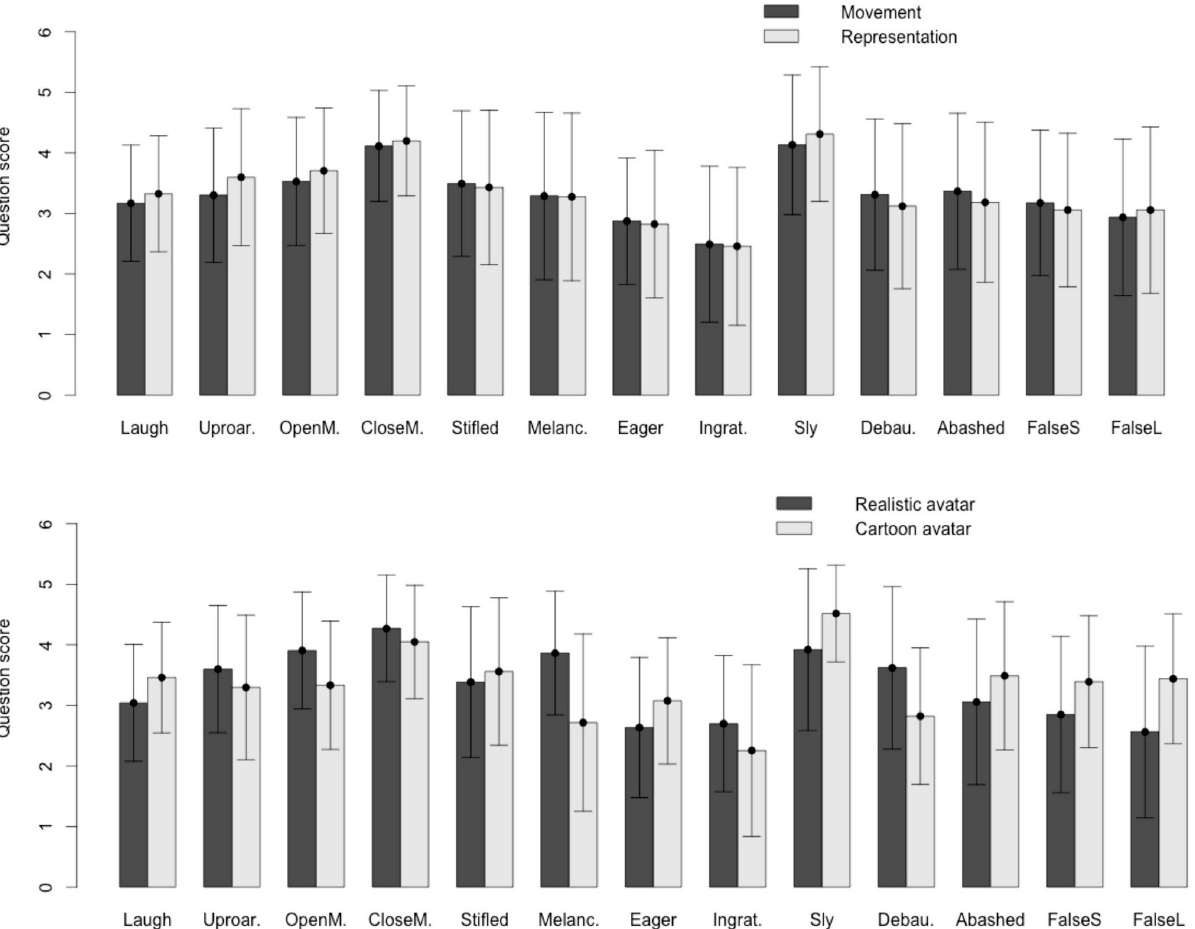
Fig 10. Mean and standard deviation (+/- SD) of the scores for both questions for all the evaluated expressions (71x13x2 = 1846 scores and 71x13x4 = 3692 scores).